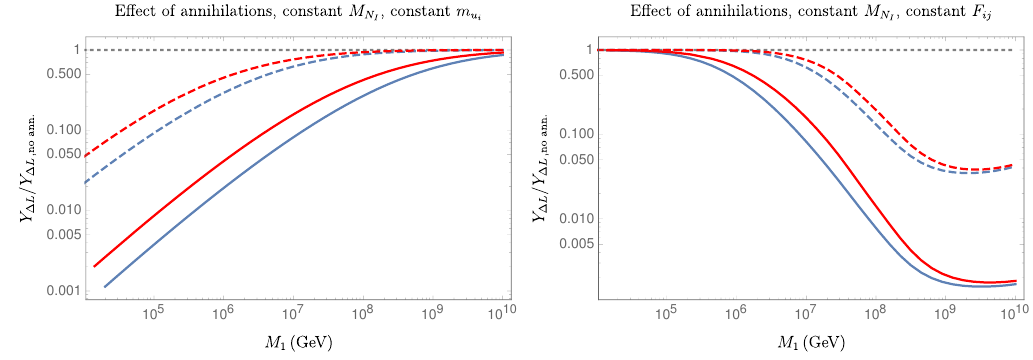
Figure 5 . Ratio of the total lepton asymmetry including annihilations vs. without annihilations , plotted as a function of M 1 . We consider time-independent M I , two (cid:13)avours of N I and three (cid:13)avours of L (cid:11) . On the left plot, the leptonic Yukawa couplings F (cid:11)I are rescaled under changes of M 1 to keep the masses of the SM (cid:23) particles constant and . 0 : 2 eV. On the right plot, we kept F (cid:11)I constant as described in the text. We assumed either M 2 = 2 M 1 (hierarchical scenario, blue lines) or ( M 2 (cid:0) M 1 ) =M 1 = 10 (cid:0) 6 (resonant scenario, red lines). Solid lines correspond to y 1 = 1, and dashed coloured lines to y 1 = 0 :